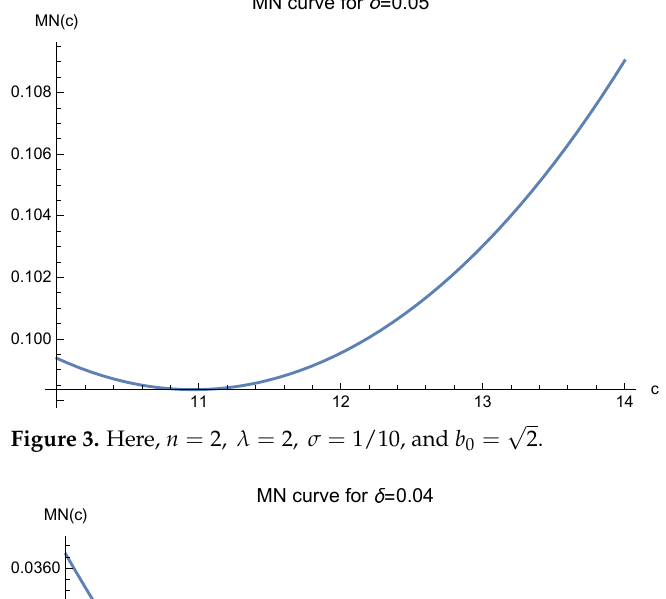
Figure 3. Here, n = 2, λ = 2, σ = 1/10, and b 0 =